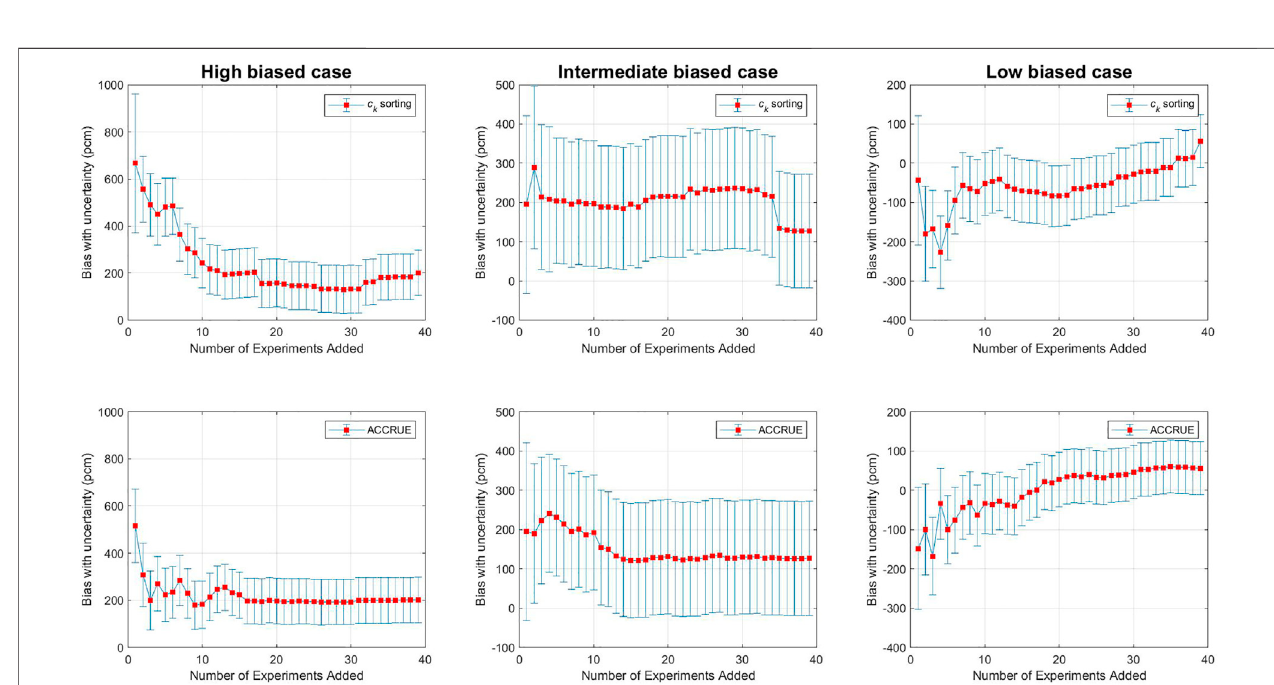
FIGURE 8 | High-relevant case layouts of the representative models. (A) Experiment model: HMF-020-001 (B) Application model: HMF-019-001.